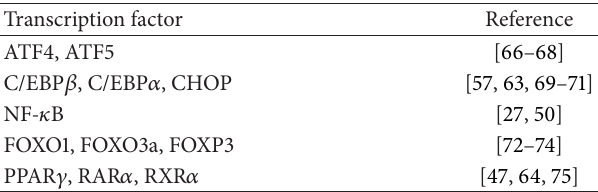
Table 1: Transcription factors that interact with TRB